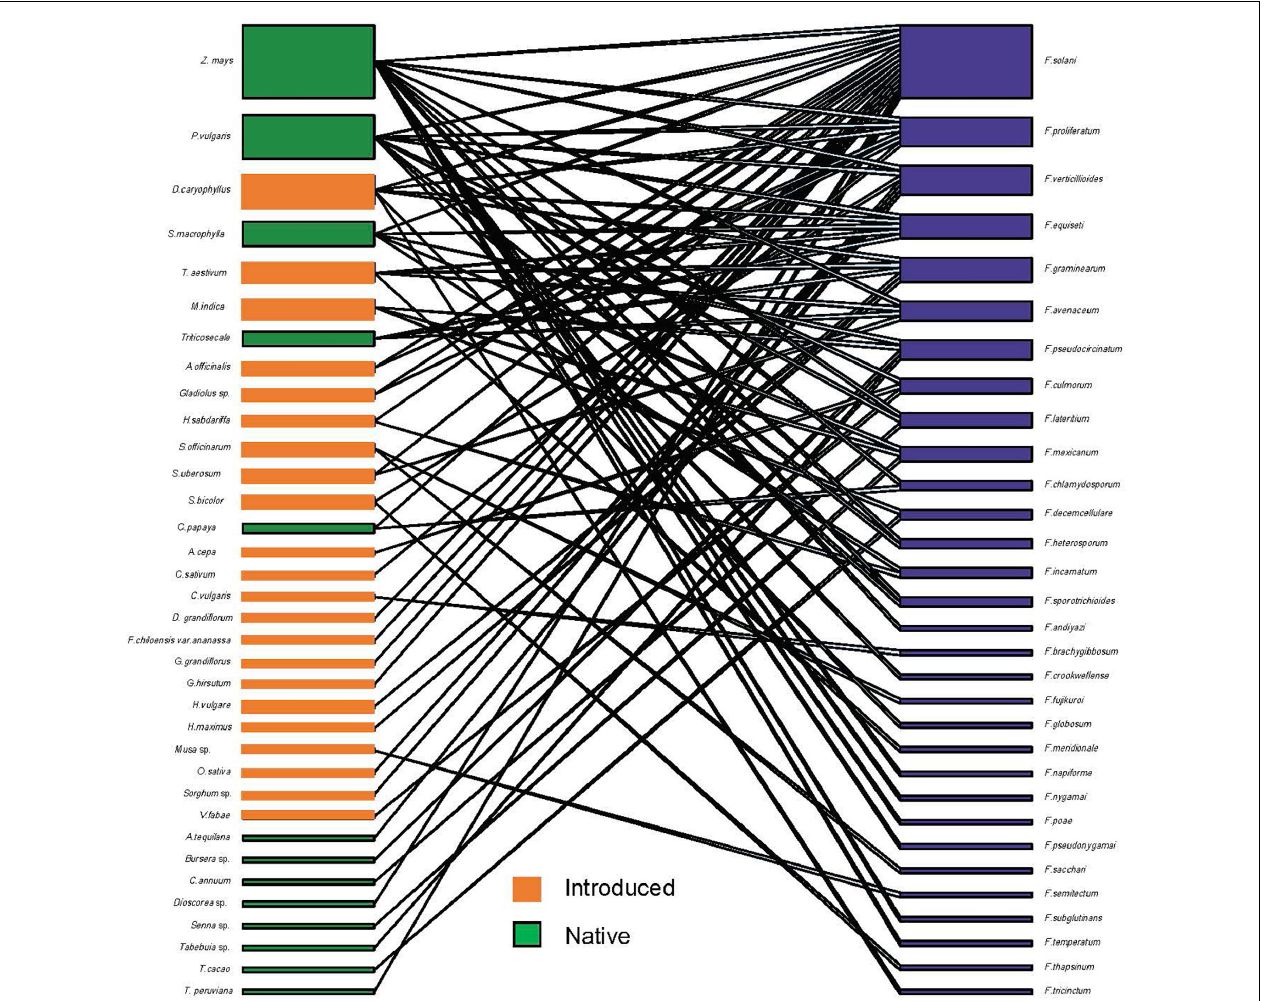
FIGURE 3 | Quantitative bipartite plot of the plant- Fusarium species ecological network for all plant species infected with known fusaria species, including the following: native plant species and introduced plant species to Mexico. The bar size represents the number of interactions each fusaria species (blue) had with each individual native (green) and introduced plant species (orange), and the linkage width represents the proportion of fusaria species involved in such